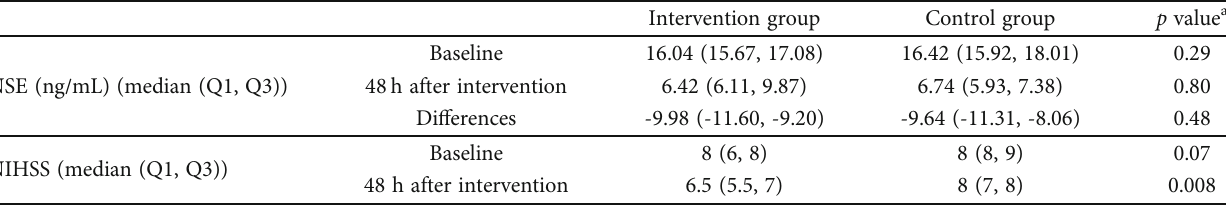
Table 2: Assessment data during study days.